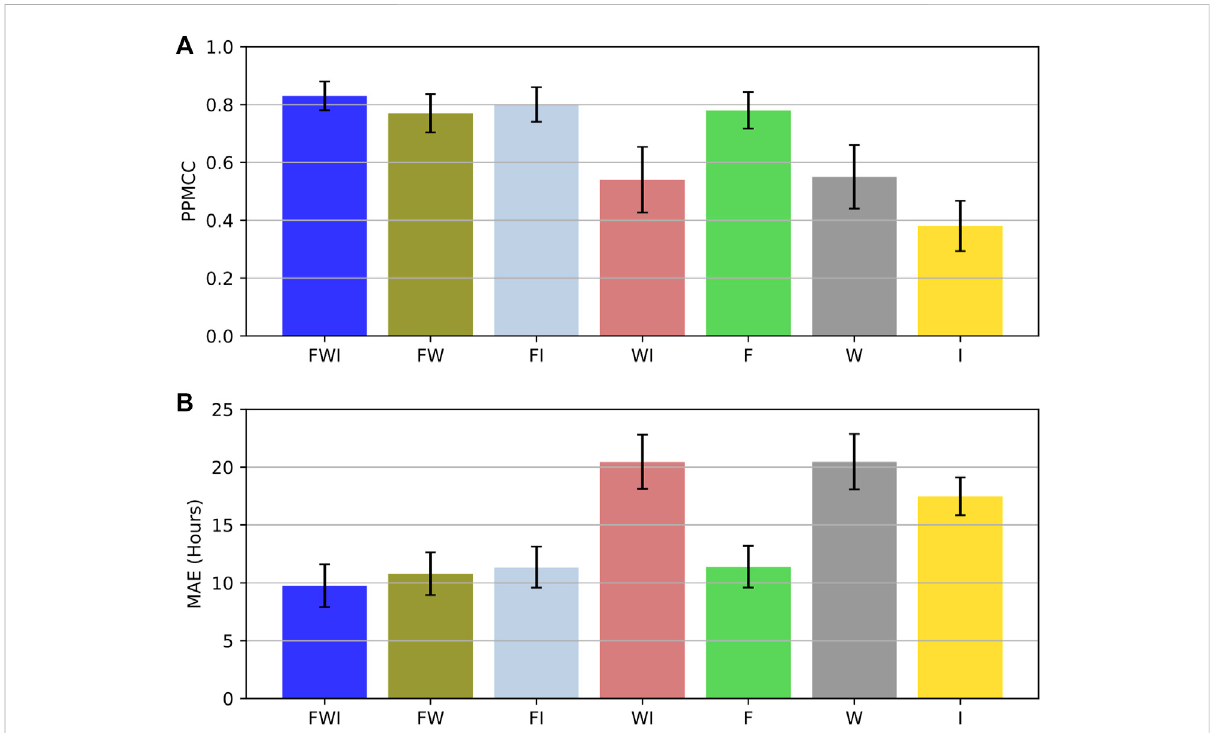
FIGURE 7 Resultsoftheablationtestsforassessingsevencases(FWI,FW,FI,WI,F,W,I)whereFWIrepresentsthecombinationofCMEfeatures,solarwind parameters and CME images, FW represents the combination of CME features and solar wind parameters, FI represents the combination of CME featuresandCMEimages,WIrepresentsthecombinationofsolarwindparametersandCMEimages,FrepresentstheCMEfeatures,Wrepresentsthe solar wind parameters, and I represents the CME images. (A) Pearson product-moment correlation coef fi cients (PPMCCs) of the tested cases. (B) Mean absolute errors (MAEs) of the tested cases. FWI yields the best performance among all the tested